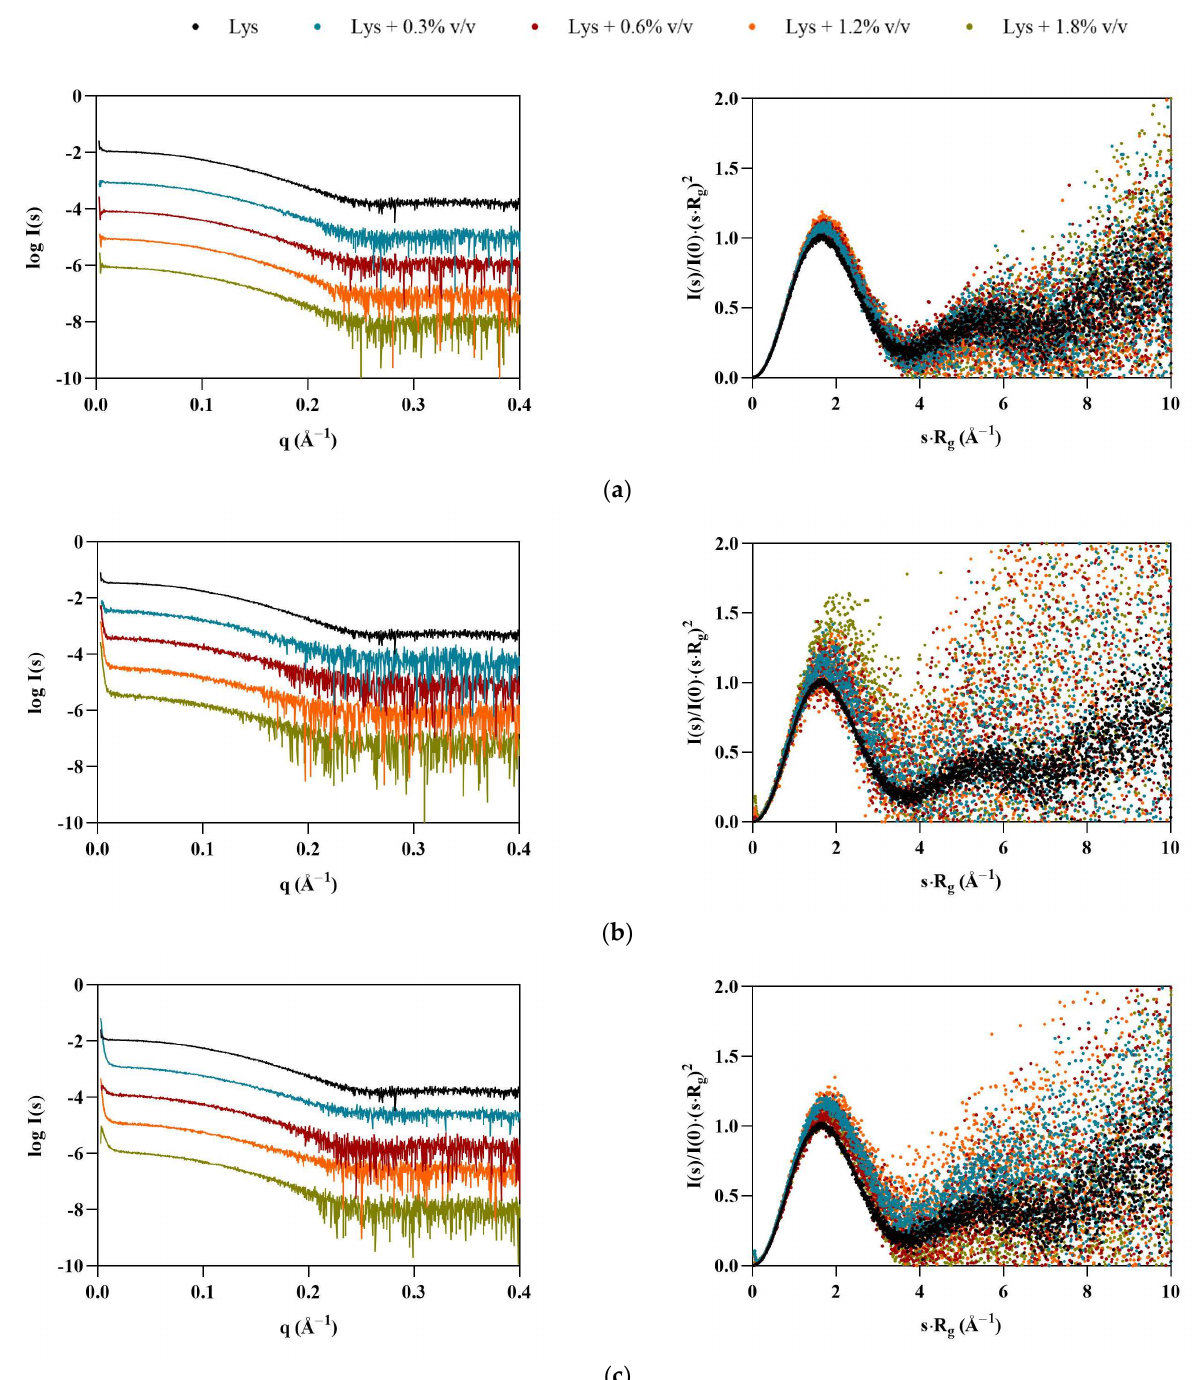
Figure 2. SAXS scaled experimental scattering curves (left) and dimensionless Kratky plots (right) for Lys in the presence of ( a ) [N 1112(OH) ][H 2 PO 4 ], ( b ) [N 1112(OH) ][C 4 F 9 SO 3 ], and ( c ) [C 2 C 1 Im][C 4 F 9 SO 3 ].